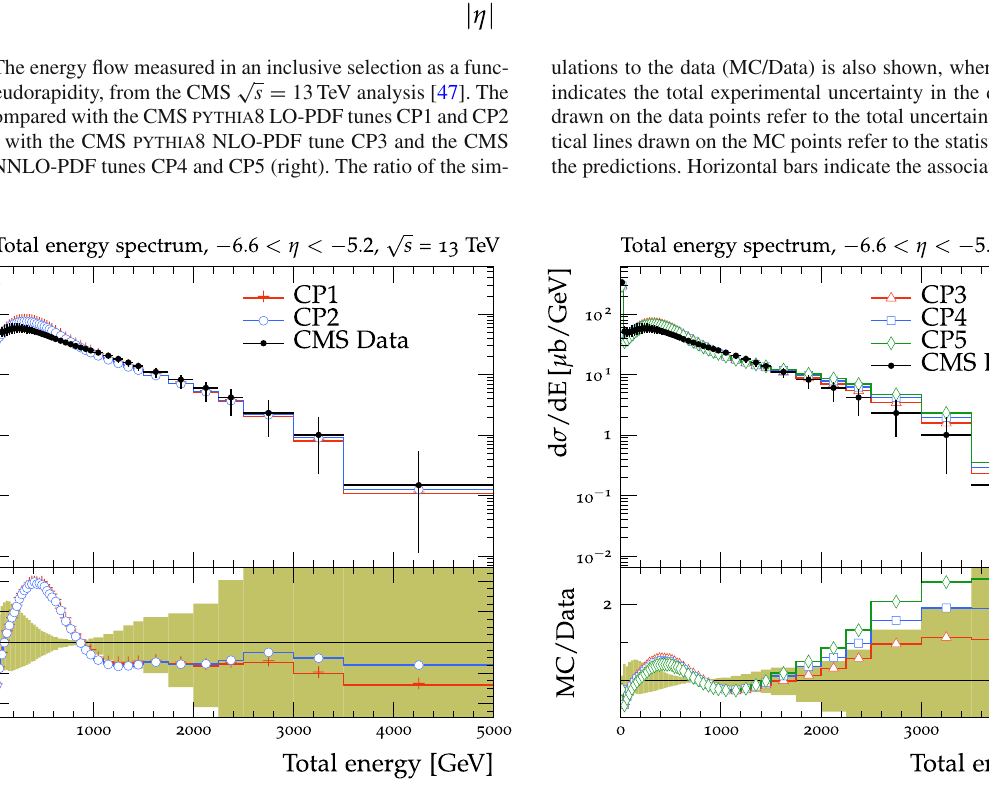
Fig. 16 The total energy spectrum measured in the pseudorapidity shaded band indicates the total experimental uncertainty in the data. √ s = 13TeV analysis Vertical lines drawn on the data points refer to the total uncertainty in interval − 6 . 6 < η < − 5 . 2, from the CMS the data. Vertical lines drawn on the MC points refer to the statistical [49]. The data are compared with the CMS pythia 8 LO-PDF tunes uncertainty in the predictions. Horizontal bars indicate the associated CP1 and CP2 (left), and with the CMS pythia 8 NLO-PDF tune CP3 bin and the CMS pythia 8 NNLO-PDF tunes CP4 and CP5 (right). The ratio of the simulations to the data (MC/Data) is also shown, where the